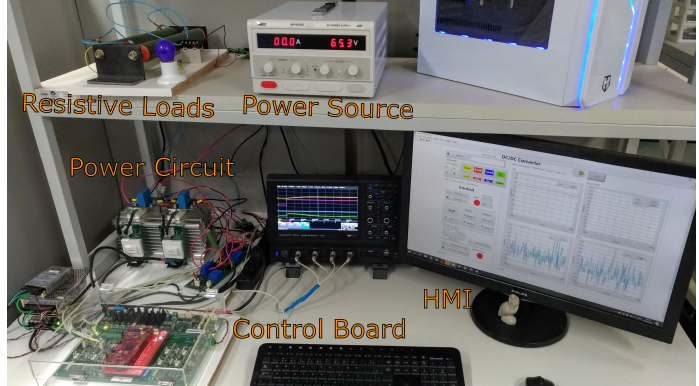
Figure 2. Experimental converter